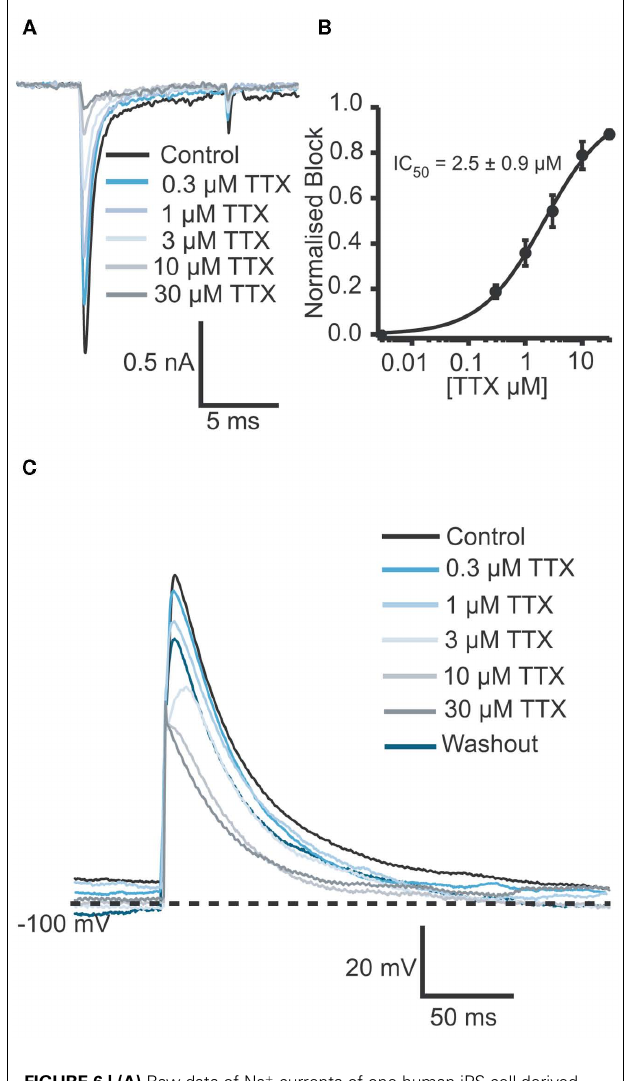
FIGURE 6 | (A) Raw data of Na + currents of one human iPS cell-derived iCell cardiomyocyte in control solution and in the presence of increasing TTX concentrations (0.3, 1, 3, 10, and 30 μ M). (B) Corresponding concentration response curve for an average of four cells reveals an IC 50 of 2.5 ± 1.0 μ M forTTX ( n = 4). (C) In the current clamp mode, aTTX concentration-dependent reduction of the amplitude as well as a concentration-dependent AP shortening was observed.The IC 50 was calculated to be 5.6 μ M ( n = 2).